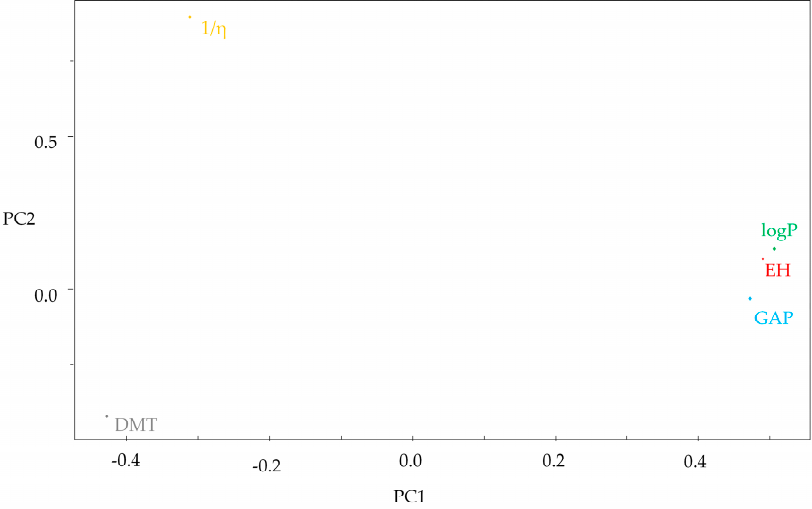
Figure 4. The plot of the PC1–PC2 loadings with the five descriptors selected.